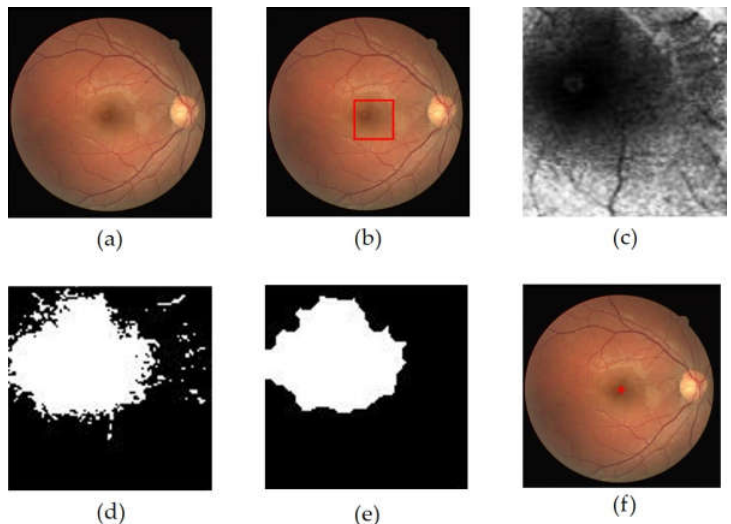
Figure 7. The extraction process results of the macular center point, ( a ) retinal image, ( b ) macular ROI localization result (red box), ( c ) macular ROI gray image, ( d ) macular ROI binarization result, ( e ) dilation + opening operation result, ( f ) macular center point detection result.